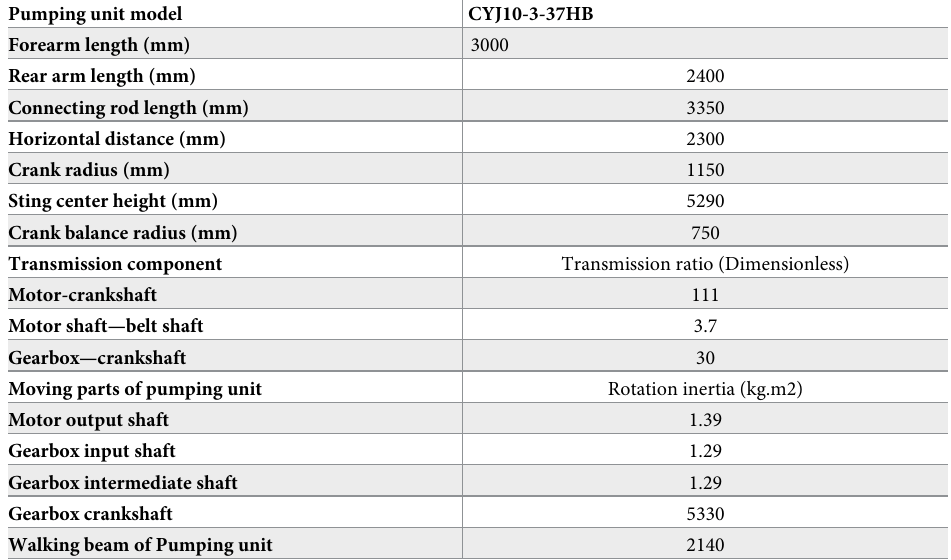
Table 1. Structure parameters of the pumping